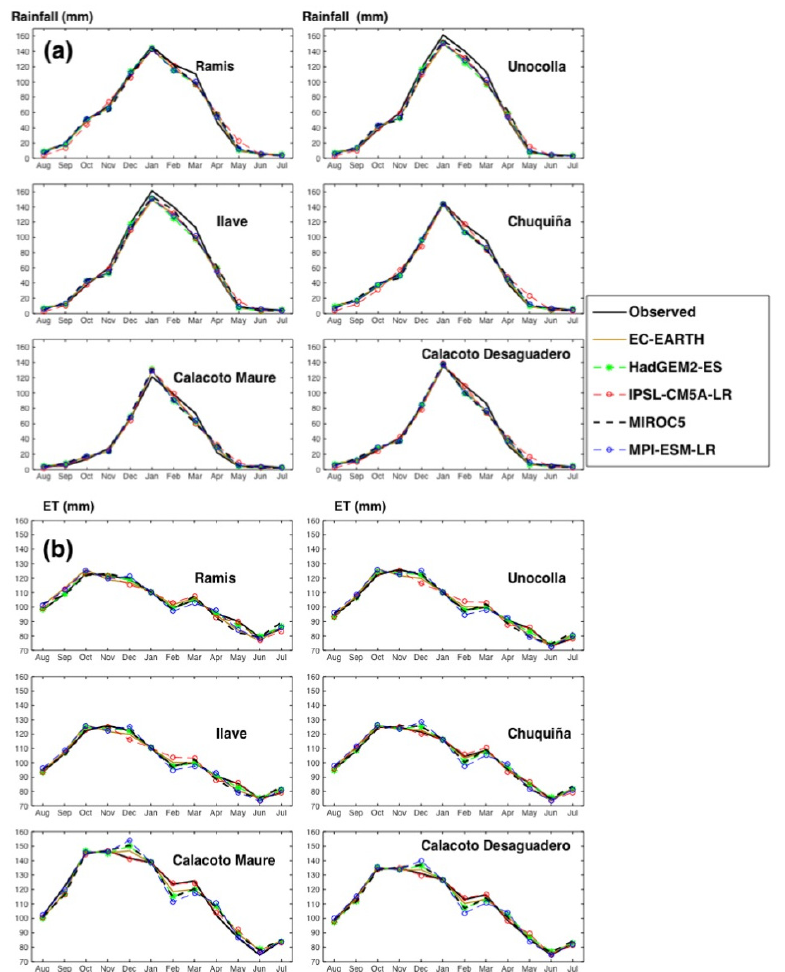
Figure 5. ( a ) Comparison of precipitation monthly means (1984–2014) between climate models (EC-EARTH, HadGeM-ES, IPSL-CM5A-LR, MIROC, MPI-ESM-LR) and observed data (mm/month), in the basins controlled at the Ramis, Unocolla, Ilave, Chuquiña, Calacoto Maure and Calacoto Desaguadero stations. ( b ) Comparison of evapotranspiration monthly means (1984–2014) between climate models (EC-EARTH, HadGeM-ES, IPSL-CM5A-LR, MIROC, MPI-ESM-LR) and observed data (mm/month) in the basins controlled at the Ramis, Unocolla, Ilave, Chuquiña, Calacoto Maure, and Calacoto Desaguadero stations. Red dots 1,2,3,4 (Peru) 7,6, and 5 (Bolivia), respectively, in Figure 1.